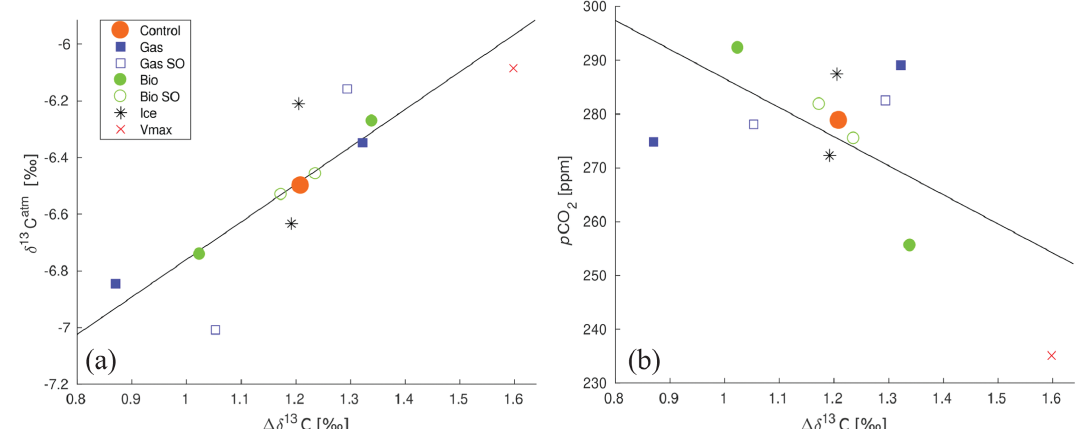
Figure 10. Relationships between global mean (cid:49)δ 13 C, δ 13 C atm , and p CO atm sensitivity experiments. R 2 of the best-fit line is 0.71, and the line is described by y = 1 . 3 x − 8 . 1. (b) Global mean (cid:49)δ 13 C versus p CO atm of the different sensitivity experiments. R 2 of the best-fit line is 0.39, and the line is described by y = − 54 x +